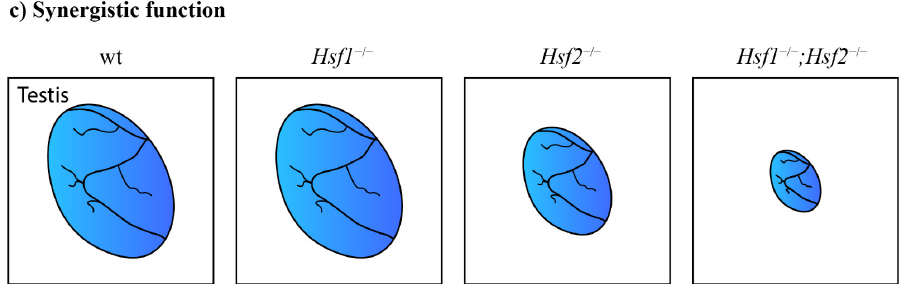
Figure 2. Functional cooperation between paralogous genes. ( a ) Paralogous genes can maintain functional redundancy and the ability to compensate for the loss of each other without phenotypic consequences. Meis1 can compensate for the lack of Meis2 and vice versa. Only the combined deletion of paralogous genes results in severe phenotypic alterations. The combined loss of Meis1 and Meis2 leads to arrested lens development [60]. ( b ) Paralogs can act additively according to the quantitative model of function. The decreased number of functional alleles causes gradual worsening of the mutant phenotype. Lack of two Onecut1/Onecut2 alleles in the mouse retina causes a dramatically decreased number of horizontal cells in any combination. One remaining Onecut1 or Onecut2 allele, similarly to the combined loss of Onecut1 together with Onecut2 , results in complete loss of horizontal cells [62]. ( c ) A synergistic interaction results in a mutant phenotype that exceeds expectations from observations of single knockouts. Hfs1 -null mice have normal testes, in contrast to Hsf2 -null mice with decreased testis size. Surprisingly, additional deletion of Hsf1 in Hsf2 -null mice causes an even more decreased testis size